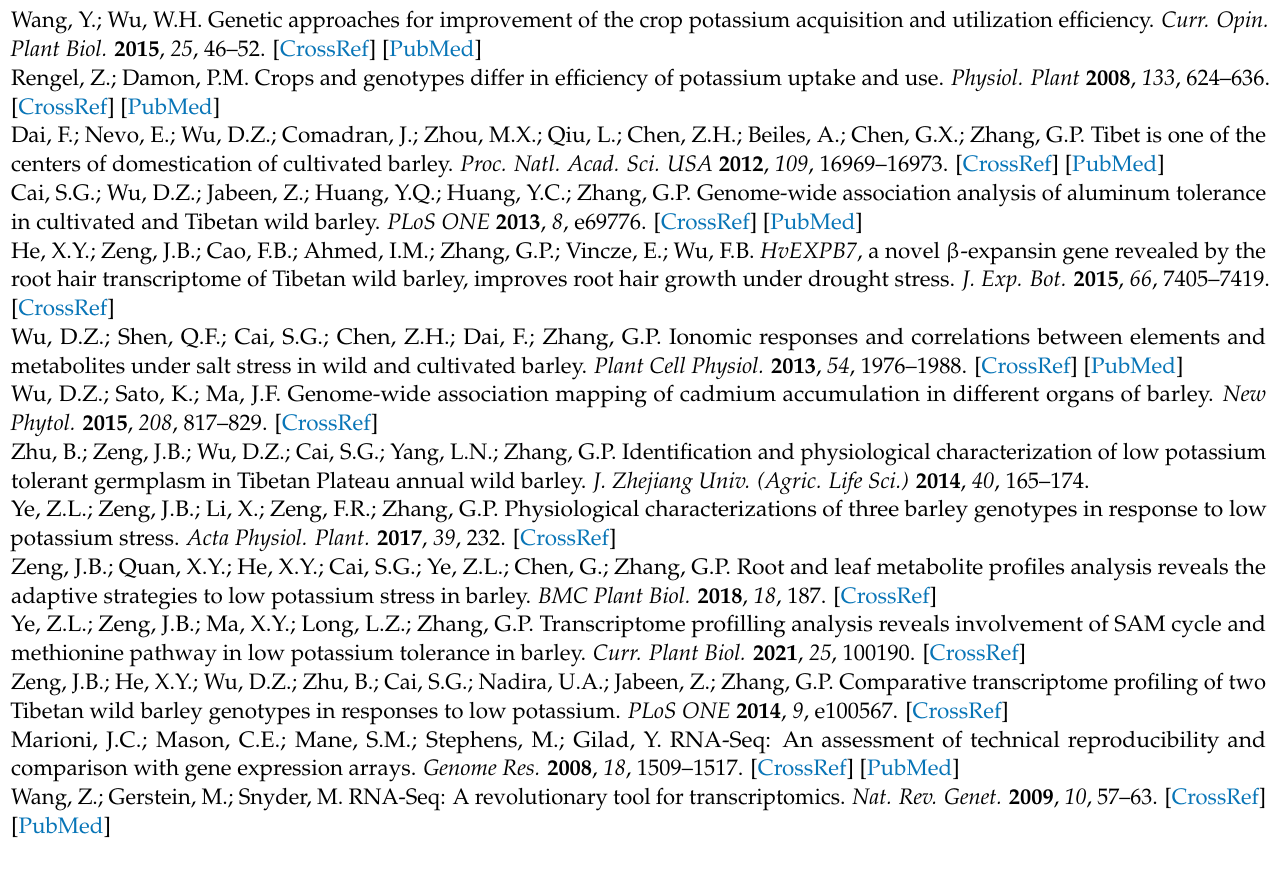
Table S3: The FPKM value of 4832 DEGs; Table S4: Gene accession numbers and sequences of 4832 DEGs; Table S5: The DEGs satisfying XZ153 condition at 48 h; Table S6: The DEGs satisfying XZ153 condition at 15 d; Table S7: Functional classification of LK-tolerance-related DEGs after 48 h LK stress; Table S8: Functional classification of LK-tolerance-related DEGs after 15 d LK stress; Table S9: Pathway analysis of LK-tolerance-related DEGs based on the KEGG data after 48 h of LK stress; Table S10: Pathway analysis of LK-tolerance-related DEGs based on the KEGG data after 15 d of LK stress; Table S11: Genes encoding TFs showing genotypic difference expression at 48 h and 15 d after LK stress; Table S12: Genes encoding protein transporters and kinases showing genotypic difference expression at 48 h and 15 d after LK